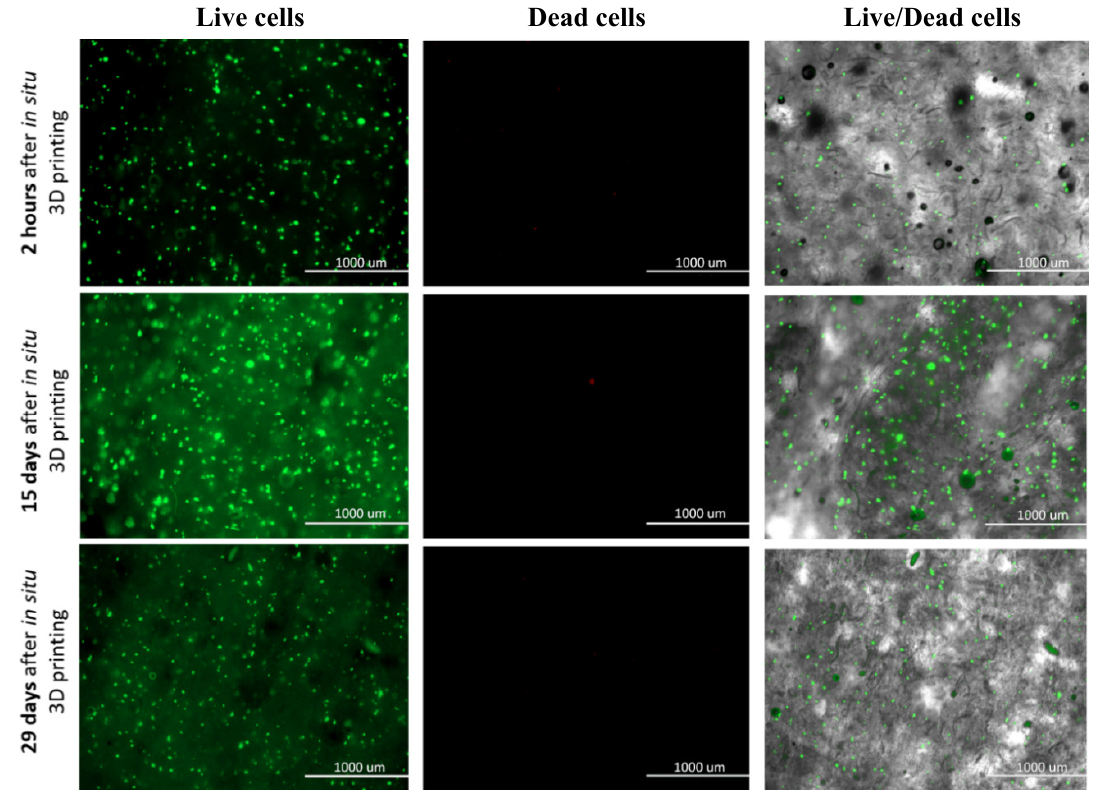
Figure 5. Live / Dead assay for 3D bioprinted hSF-Laden sca ff olds (all time points are shown in the Figure 5. Live/Dead assay for 3D bioprinted hSF-Laden scaffolds (all time points are shown in the Supplementary Materials—Figures S2 and Supplementary Materials—Figures S2 and S3).